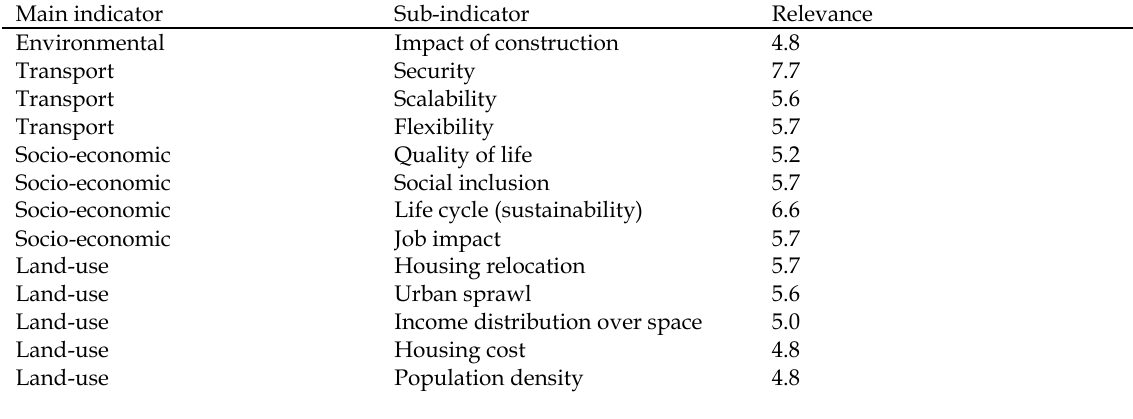
Table 3. KPIs for the qualitative assessment of the case